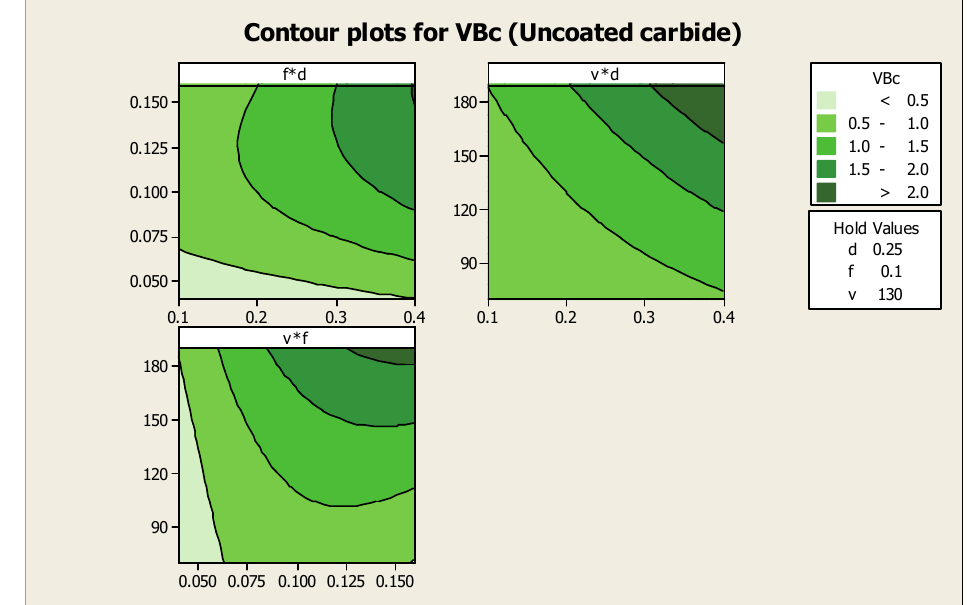
Fig. 12. Contour plots for flank wear (VBc)